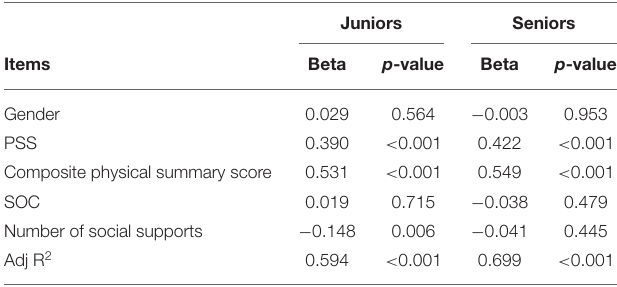
TABLE 4 | Determinants of Composite mental summary scores by grade